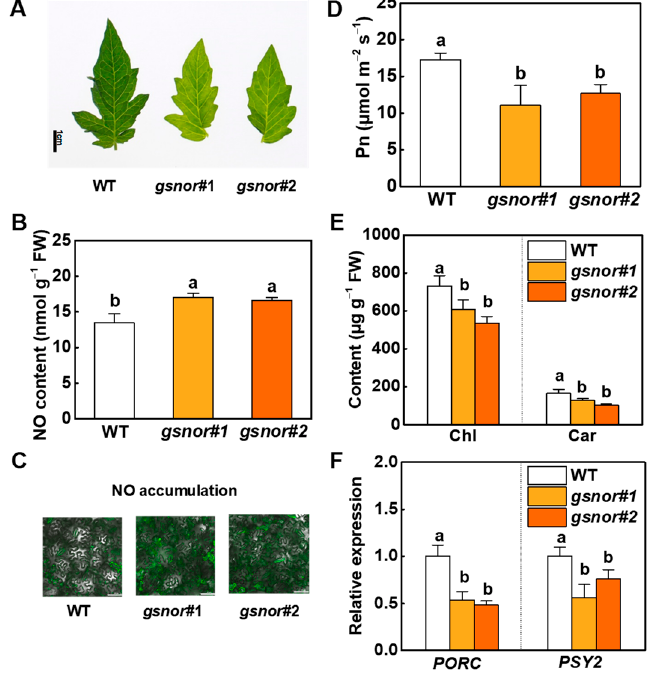
Figure 1. GSNOR regulates photosynthetic pigment biosynthesis through endogenous nitric oxide (NO) in tomato plants. ( A ) Leaf phenotypes of the wild type (WT), gsnor#1 , and gsnor#2 plants. Bar represents 1 cm. ( B , C ) Nitric oxide (NO) accumulation, ( D ) photosynthesis rate (Pn), ( E ) chlorophyll and carotenoid contents of leaves, and ( F ) relative transcript levels of PROTOCHLOROPHYLLIDE OXIDOREDUCTASE (PORC) and PHYTOENE SYNTHASE (PSY2) in WT, gsnor#1 , and gsnor#2 . For ( C ), NO accumulation in leaves was visualized using a NO ‐ specific fluorescent probe, 3 ‐ Amino,4 ‐ aminomethyl ‐ 2 ′ ,7 ′‐ difluorescein, and diacetate (DAF ‐ FM ‐ DA), and fluorescence was photographed with a laser scanning confocal microscope (Nikon A1plus, Japan). Representative images were selected from eight replicates; horizontal bars = 50 μ m. For other determinations, data are shown as means ± SD ( n = 3). Different letters indicate significant differences at p < 0.05 according to Tukey’s test.